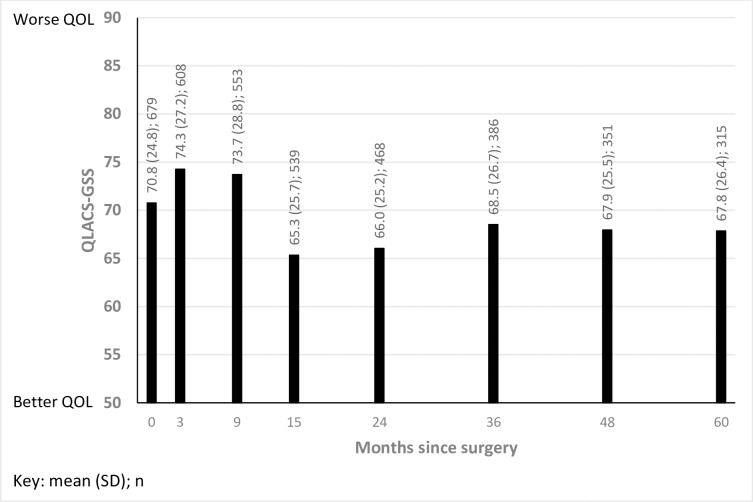
Mean scores (and standard deviations) of the QLACS-GSS.